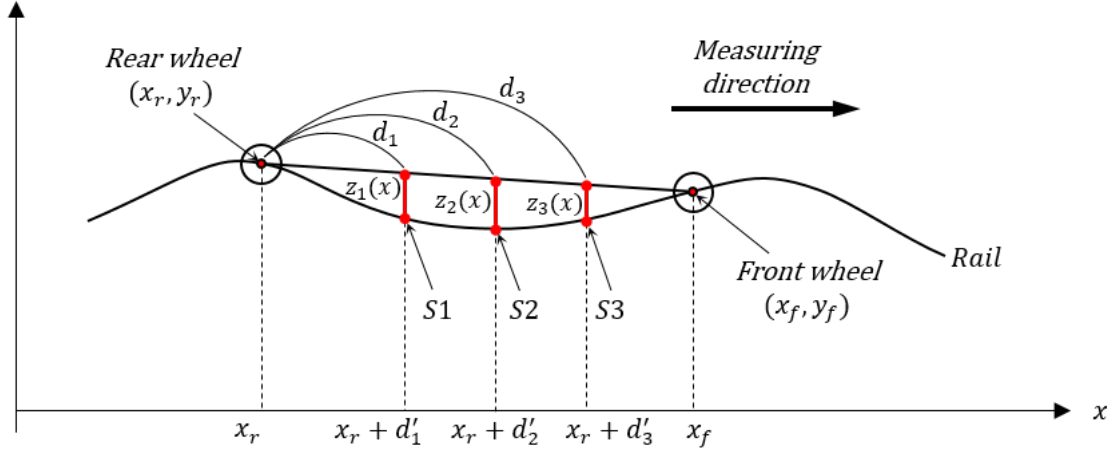
Figure 6. Multi-sensor-based chord offset synchronizing model ( α i = d i / L , and d i is the distance from x r to the i th sensor ( i = 1, 2,